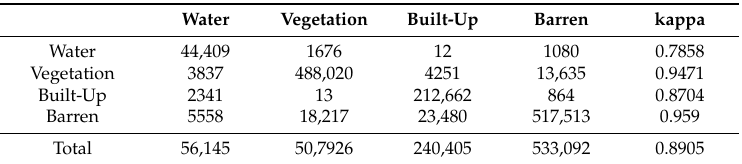
Table 7. Overall kappa statistic between each class of satellite-derived LULC maps and CA-Markov estimated maps for 2013 in Peshawar